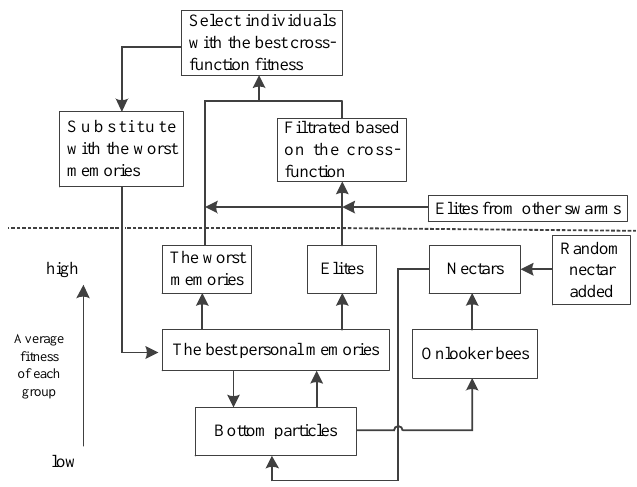
Figure 2. Evolutionary structure of the ParaPA